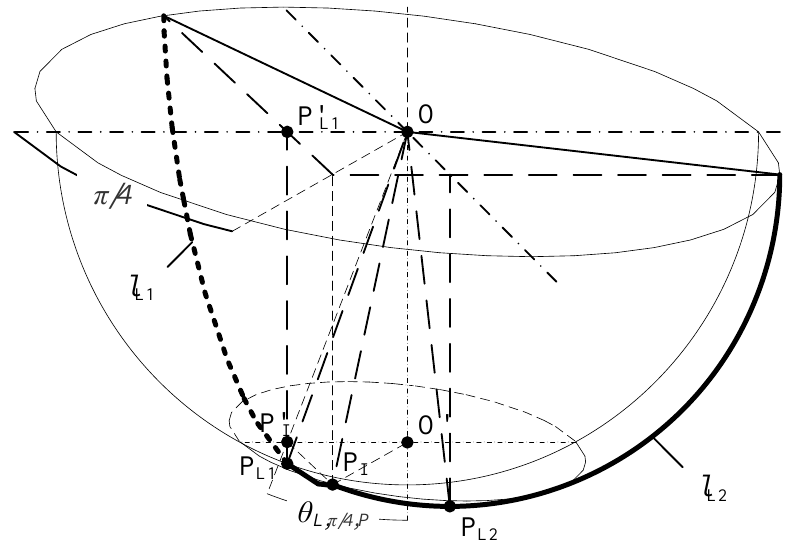
Figure A7. Ω L geometric sketch 2.